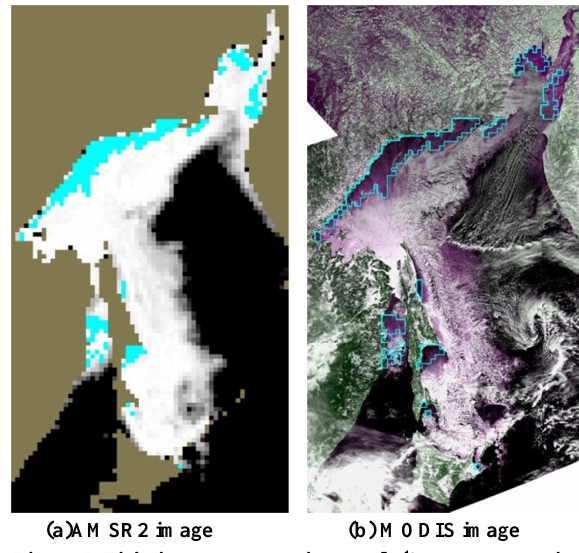
Figure 5 . Thin ice area ext